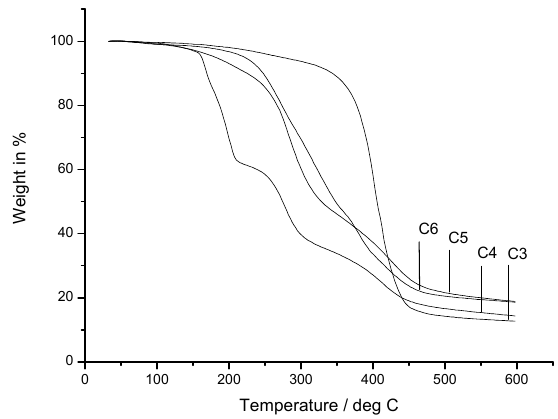
Figure 6. TGA measurement of nonquaternized C3 and quaternized copolymers: C4 (-N(CH 3 ) 3+ ), C5 ((-N(CH 3 ) 3+ + -N(CH 3 ) 2 C 12 H 25+ ), and C6 (-N(CH 3 ) 2 C 12 H 25+ ).